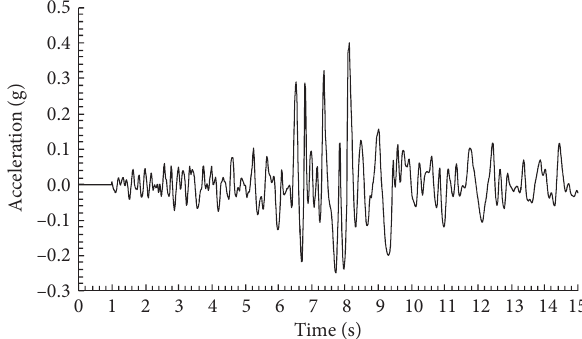
Figure 4: Acceleration time-history curve of Northridge